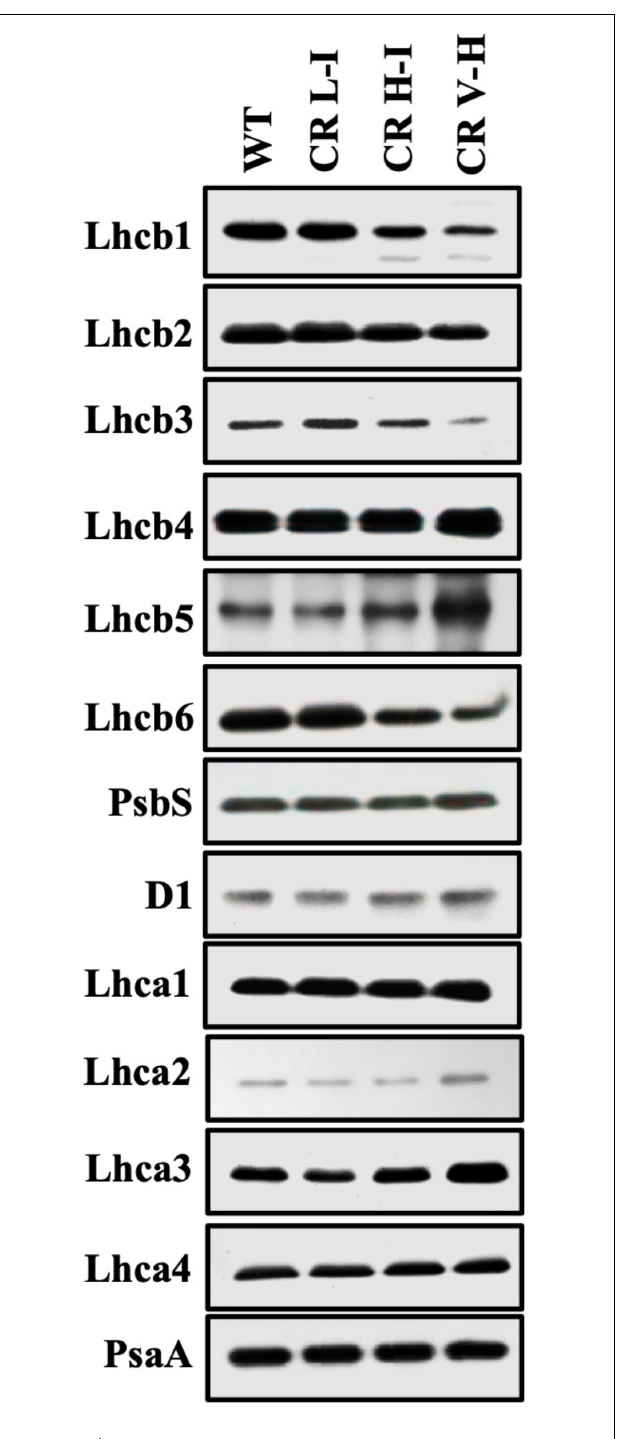
FIGURE 3 | Comparison of thylakoid protein contents in wild-type and CAO RNAi transgenic lines. Thylakoid membranes were isolated from overnight dark-adapted wild-type (WT), CR L-I (Chl a/b = 4.5–6.5), CR H-I (Chl a/b = 6.5–8.5), and CR V-H (Chl a/b 8.5 or above) transgenic plant leaves. Thylakoid membrane contents 2 µ g Chl were separated by the sodium dodecyl sulfate-polyacrylamide gel electrophoresis (SDS-PAGE) and immunoblotted using specific antibodies raised against Lhcb1, Lhcb2, Lhcb3, Lhcb4, Lhcb5, Lhcb6, Lhca1, Lhca2, Lhca3, Lhca4, D1, PsbS, and